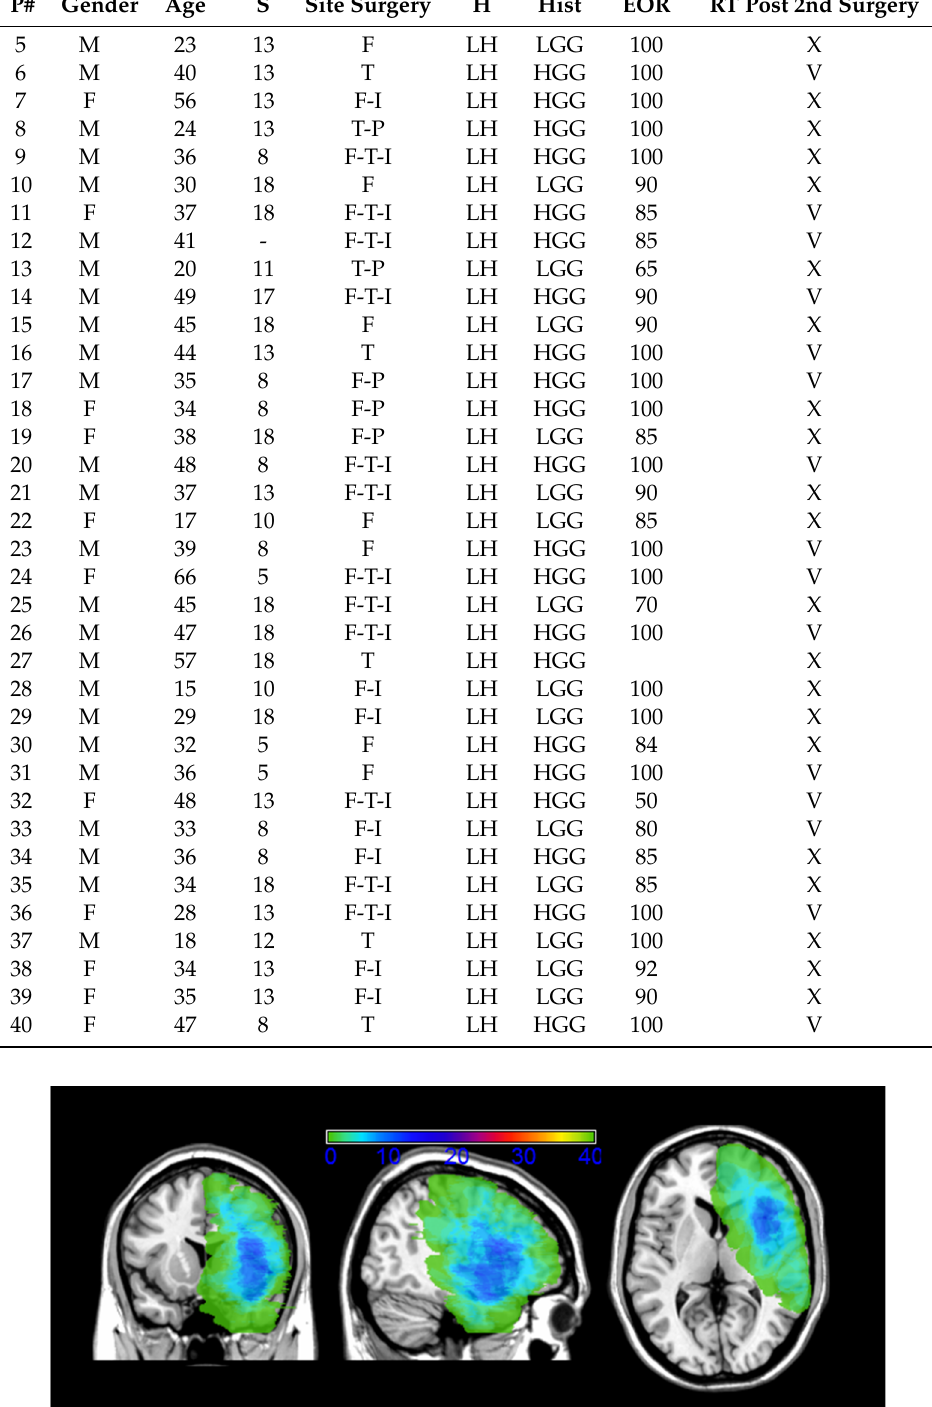
Figure 1. Overlap of all the 40 pre-recurrence (T3) patients’ lesions masks. Lesion masks include both the surgical cavity of the first surgery and the lesion regrowth. The number of overlapping lesions is illustrated by different colors coding increasing frequencies (as indicated in the bar code). As shown by the image, the epicenter of the overlap is located at the level of the frontotemporoinsular region. MR images are displayed in radiological convention.